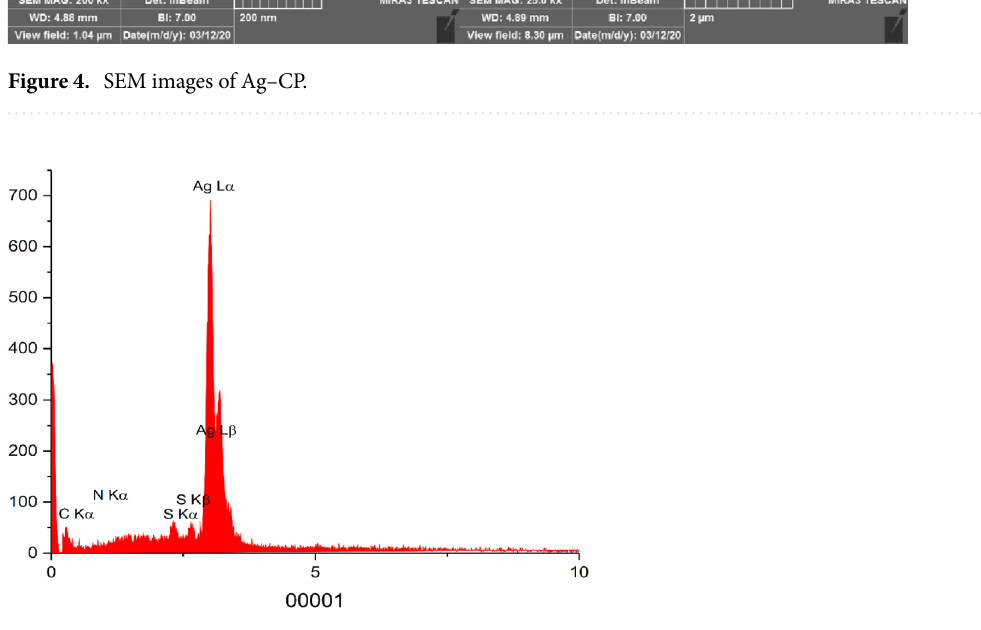
Figure 5. EDX Analysis of